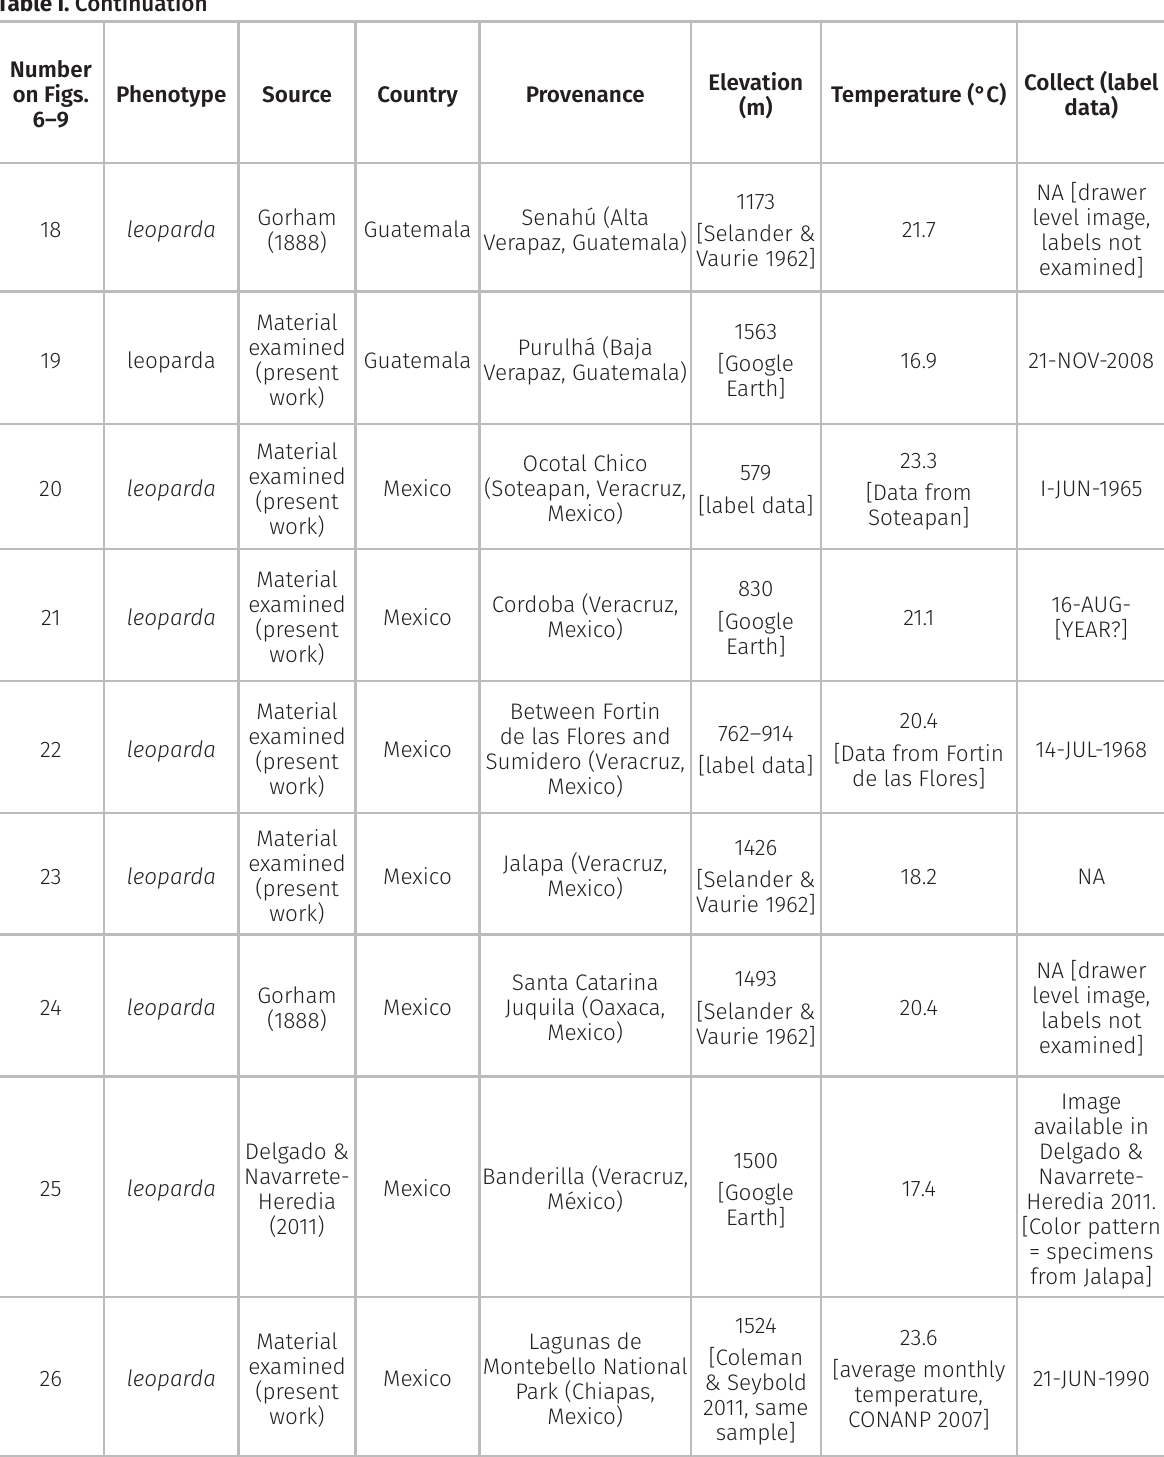
Table I. Number on Figs.